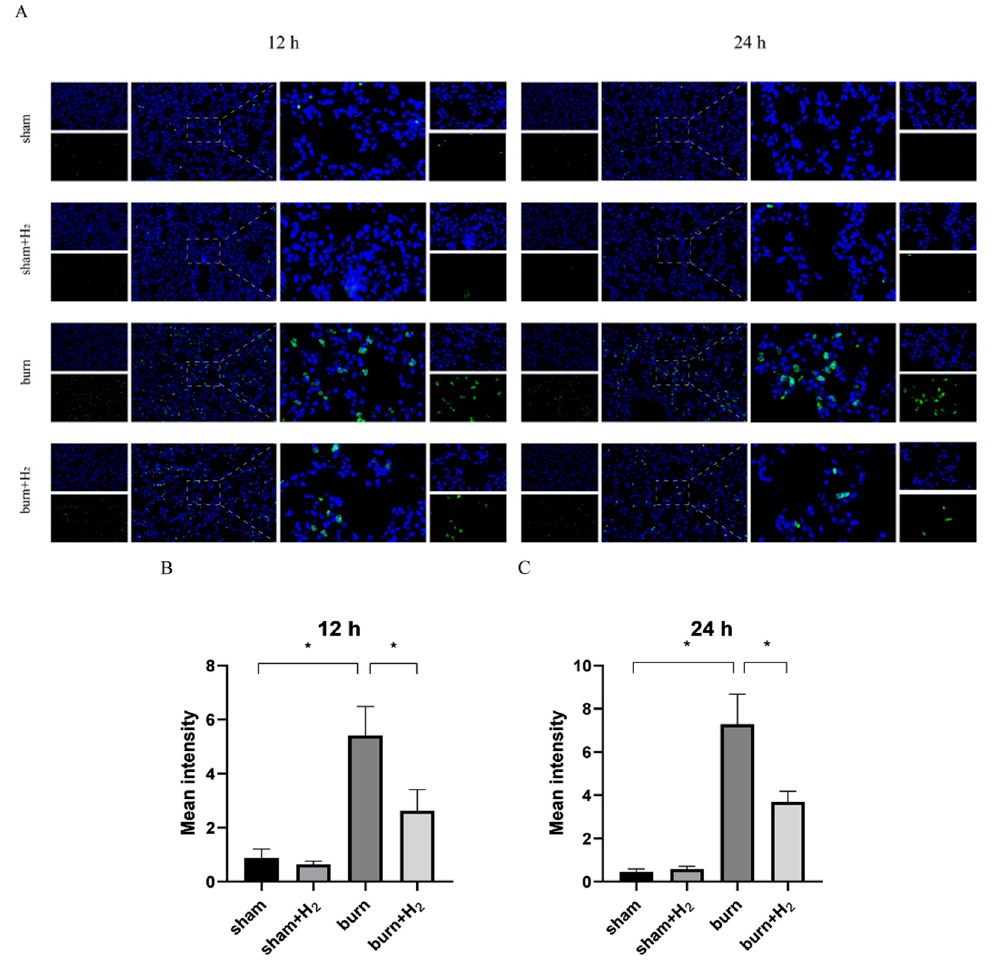
Figure 5. Hydrogen reduced the expression of GSDMD caused by burn. The distribution of GSDMD was detected by immunofluorescence at 12 and 24 h ( A ). The density of GSDMD was analyzed ( B , C ) ( n = 4 rats per group). * p < 0.05.